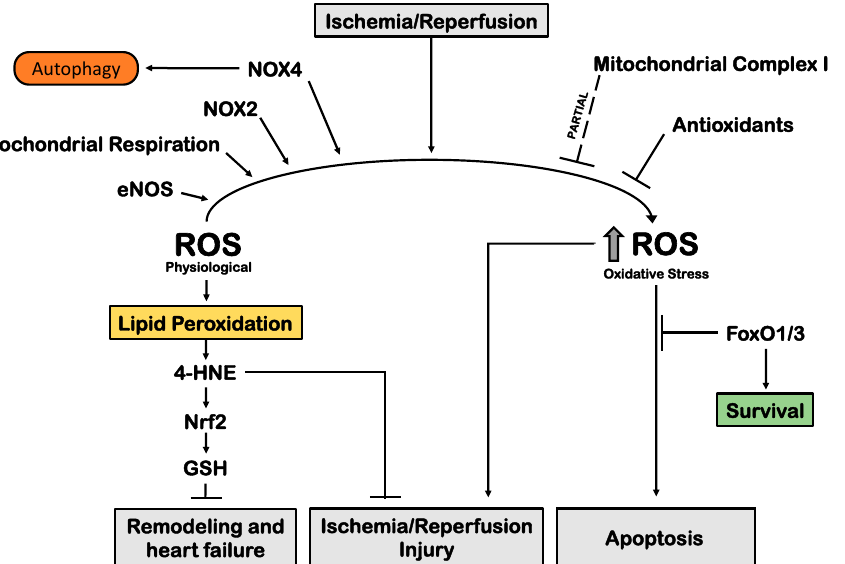
Figure 4. Schematic representation of the main pathways contributing to oxidative stress during myocardial ischemia. Physiological levels of ROS preserve cardiac function, whereas their increase enhances ischemia/reperfusion injury. 4-HNE, 4-hydroxynonenal; eNOS, endothelial nitric oxide (NO) synthase; GSH, glutathione; FoxO1/3, Forkhead Box O1; NOX2/4, nicotinamideadenine-dinucleotide phosphate (NADPH) oxidase 2/4; Nrf2, NF-E2–related factor 2; ROS, reactive oxygen species.